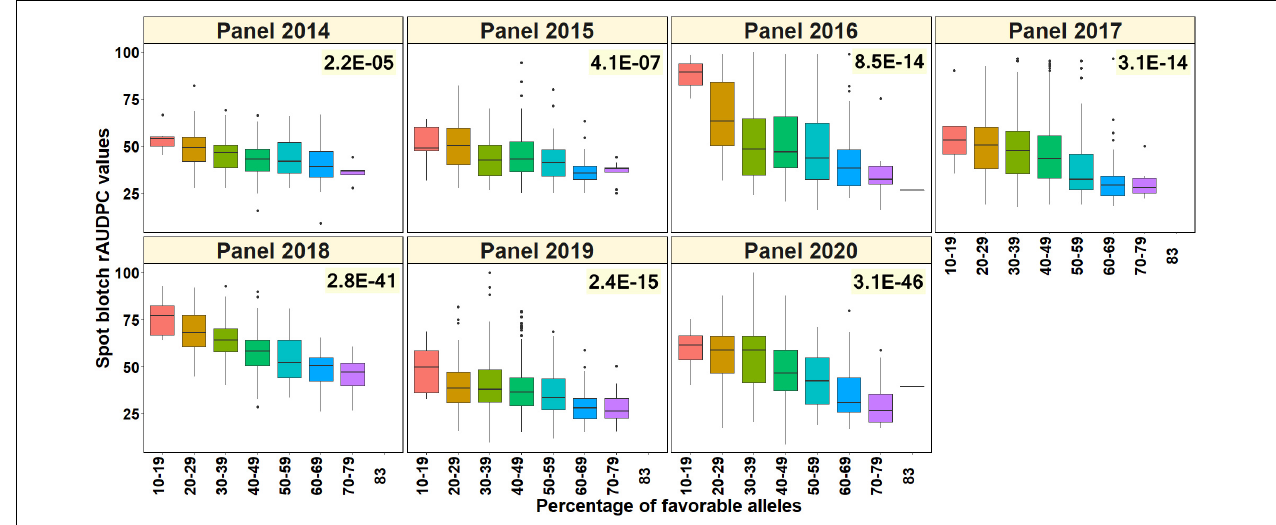
FIGURE 6 | Percentage of favorable alleles (alleles that have a decreasing effect on spot blotch) in the lines from different panels plotted against the spot blotch relative area under the disease progress curve (rAUDPC) values in seven panels. The values on the top right of the panels indicate the two-sided p -values for the test that there is no relationship between the percentage of favorable alleles and the spot blotch rAUDPC values of the lines against the alternate hypothesis that there is a relationship.